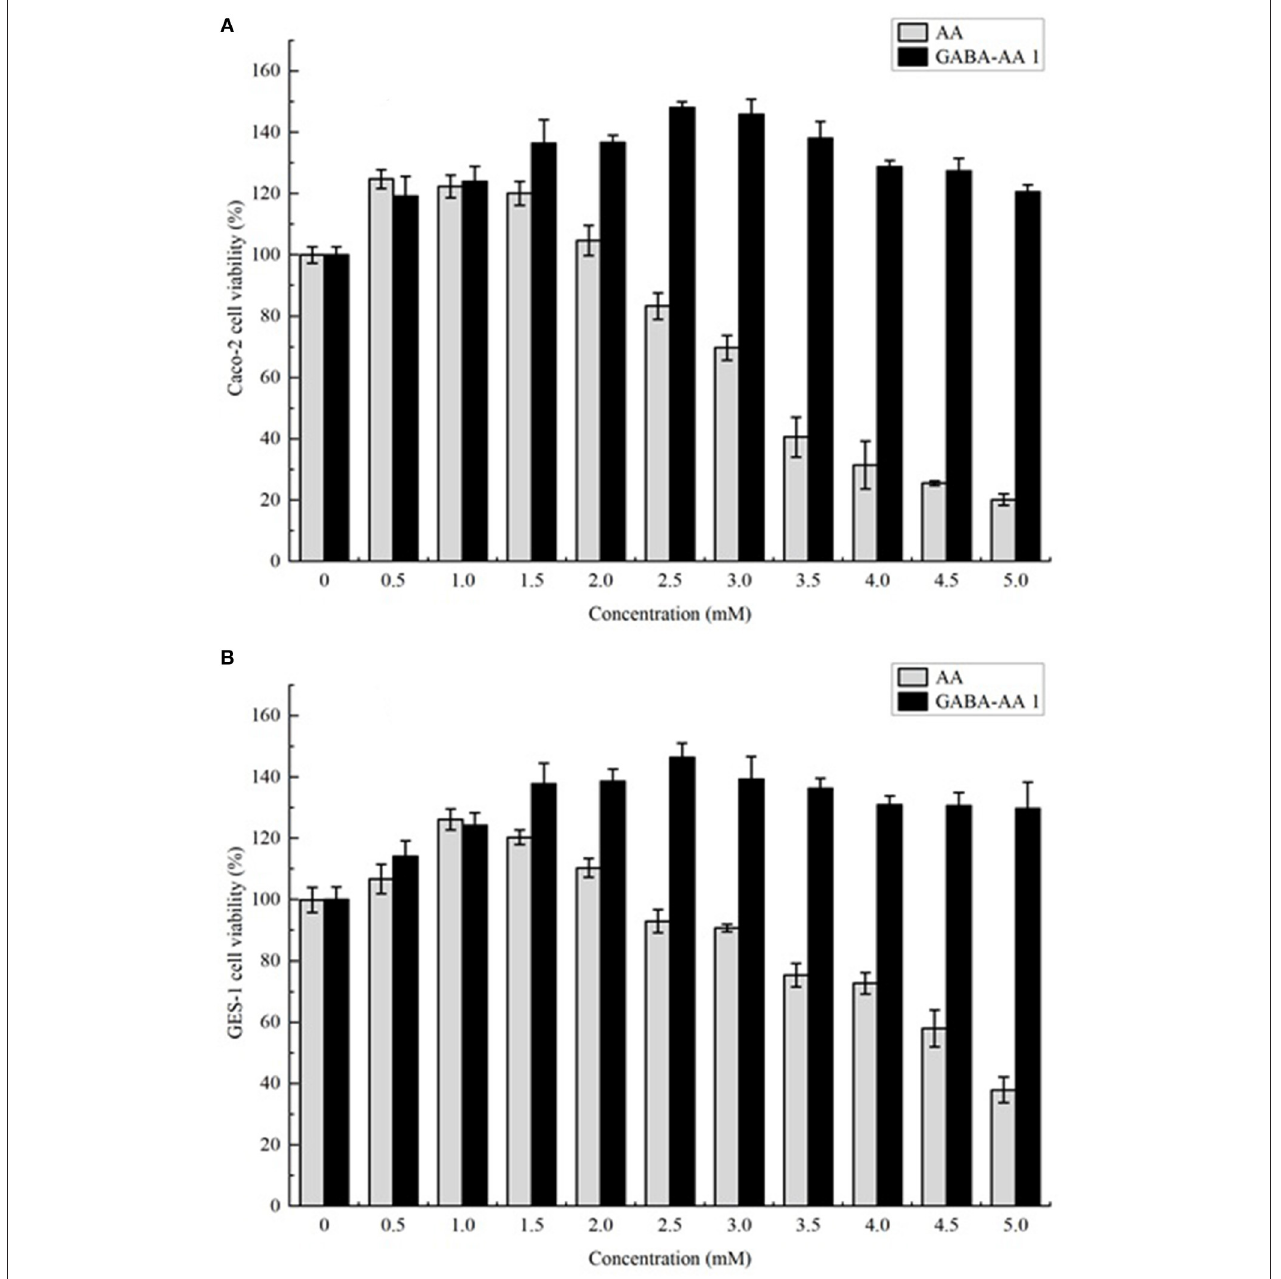
FIGURE 5 | The cytotoxicity of AA and its adduct GABA-AA 1 towards Caco-2 (A) and GES-1 (B) cells.